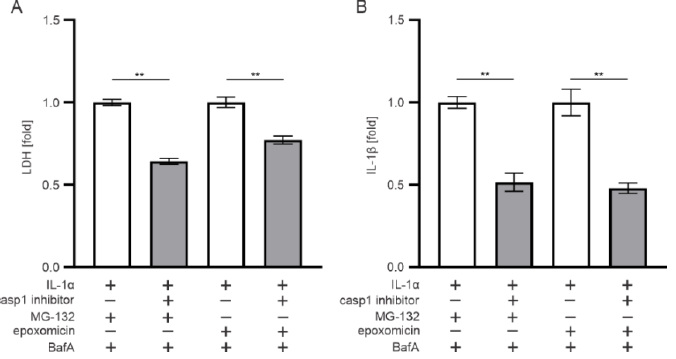
Figure 3. The effect of caspase-1 (casp1) inhibition on ( A ) cell viability and ( B ) IL-1 β secretion in ARPE-19 cells exposed to epoxomicin or MG-132 and BafA. Data of LDH and IL-1 β were combined from three independent experiments with four parallel samples in each group. The results are presented as mean ± SEM. ** p ≤